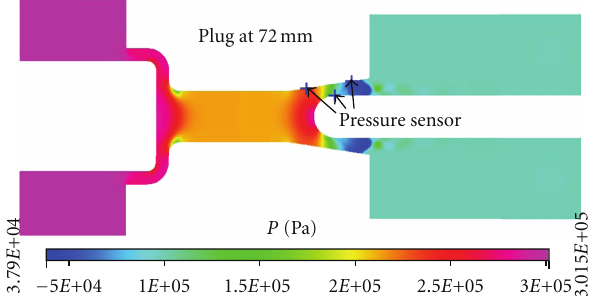
Figure 6: Transonic flow configuration at nozzle opening (72 mm